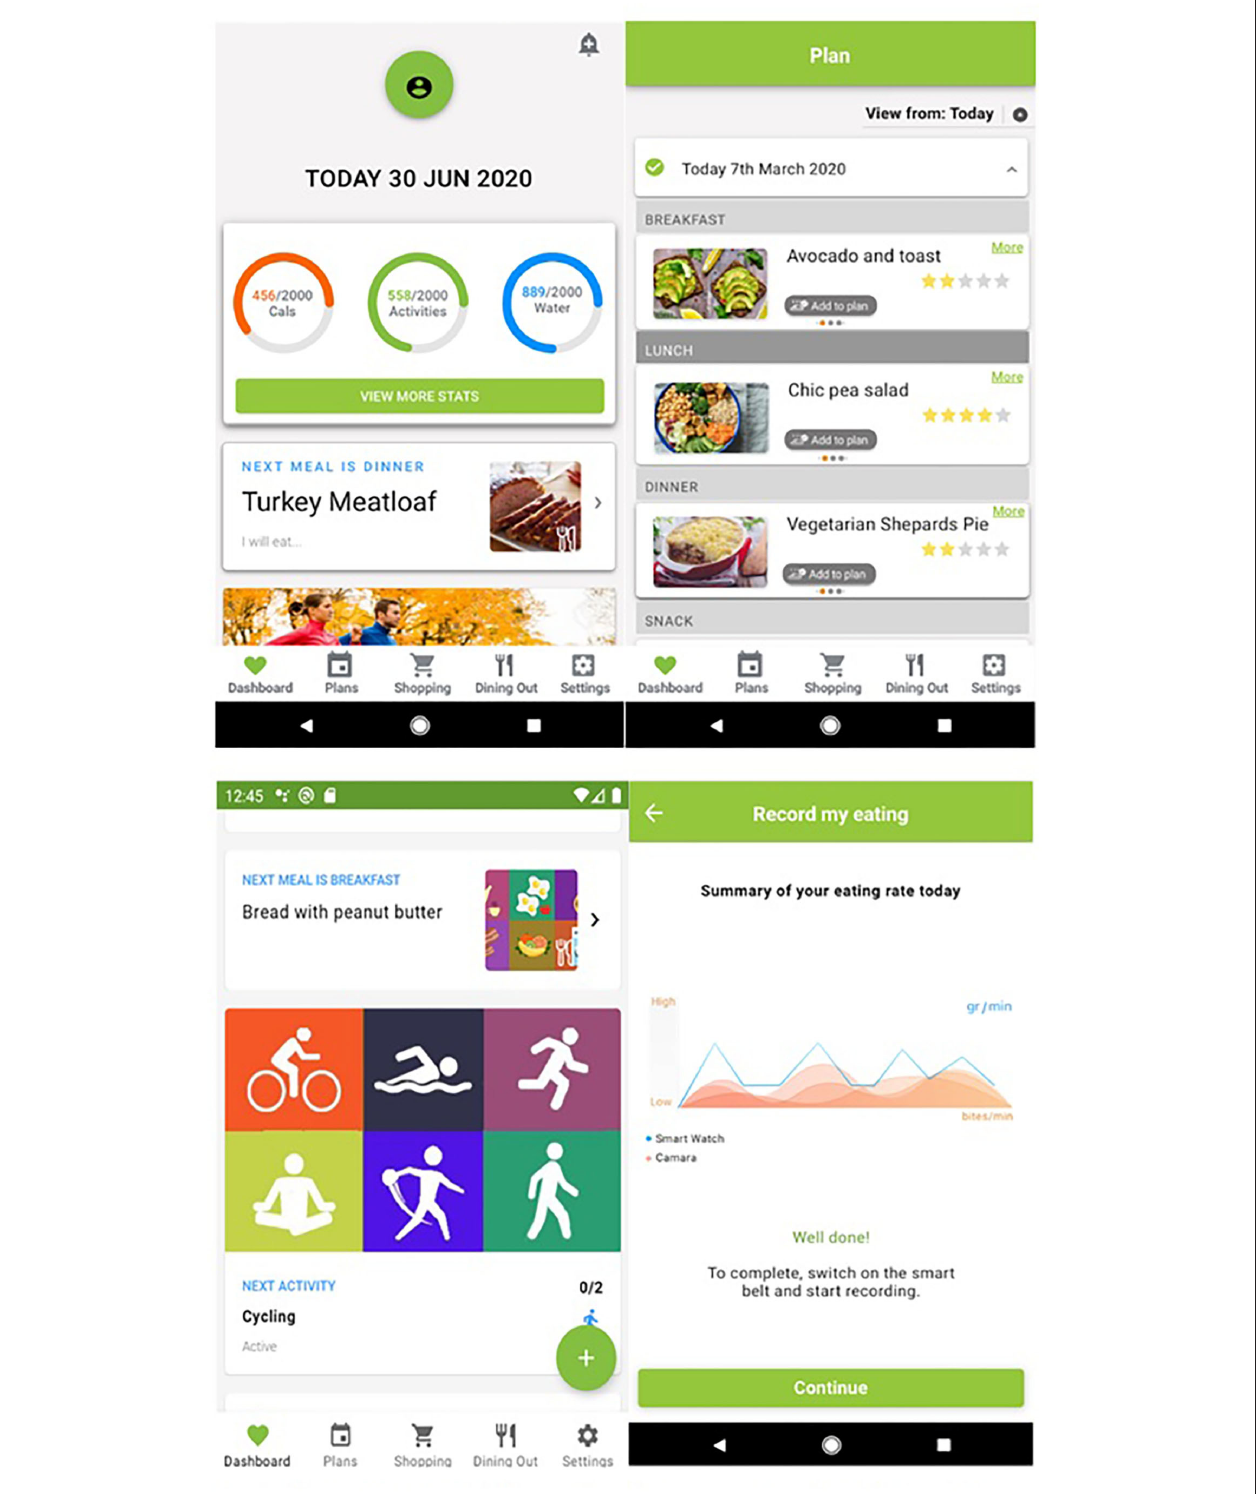
FIGURE 1 | Screen shots of the PROTEIN mobile application [Source: Google Play Srore].